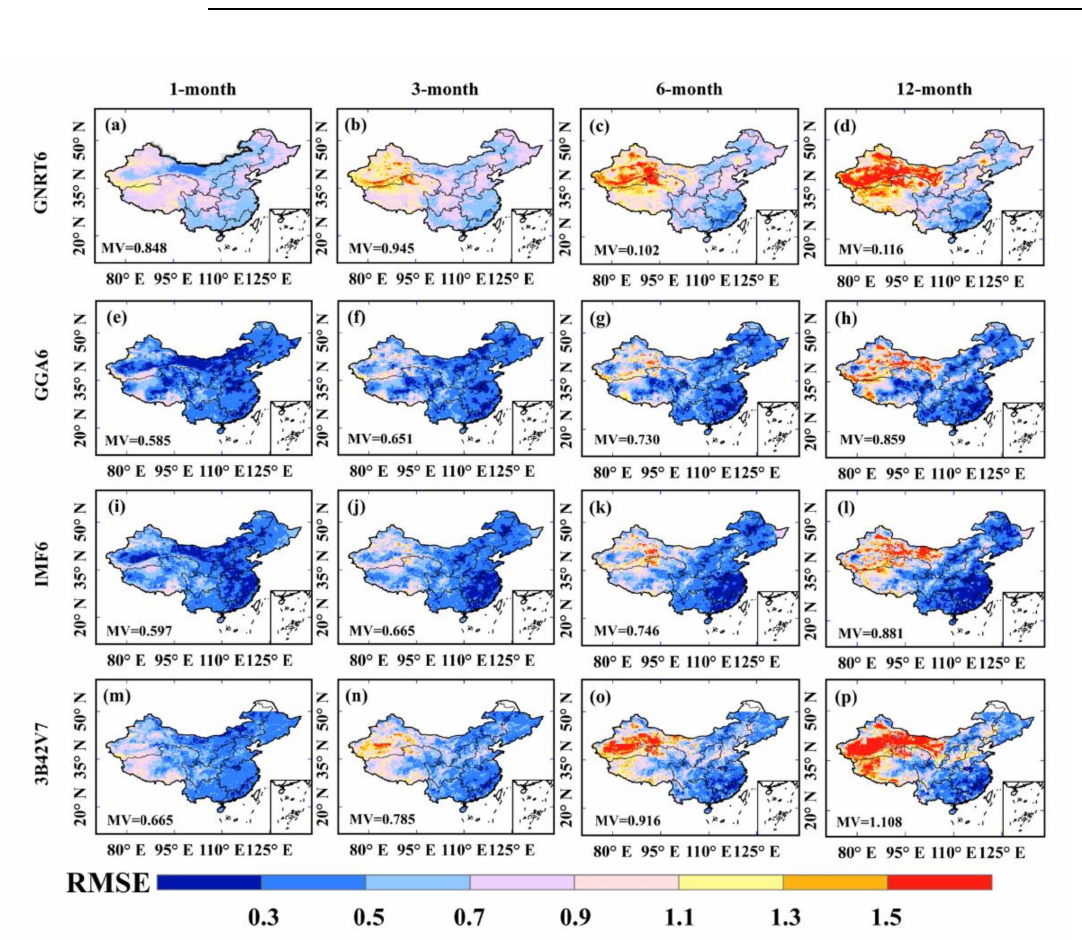
Figure 5. RMSE of the ( a , e , i , m ) 1-, ( b , f , j , n ) 3-, ( c , g , k , o ) 6- and ( d , h , l , p ) 12-month SPEI based on the four SREs w.r.t in situ observa-tions in June 2000–May 2019. Columns for different time scales, rows for different